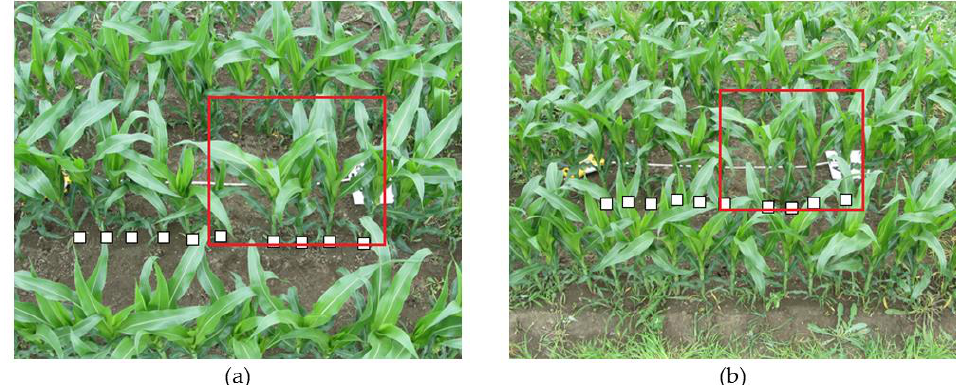
Figure 5. Oblique images of a sampling area photographed with the zip line camera at viewing angles of ( a ) 30° and ( b ) 45° from the vertical. The sampling quadrat (length L = 1 m) is shown as a red rectangle and the sampled plants are identified with white square markers.